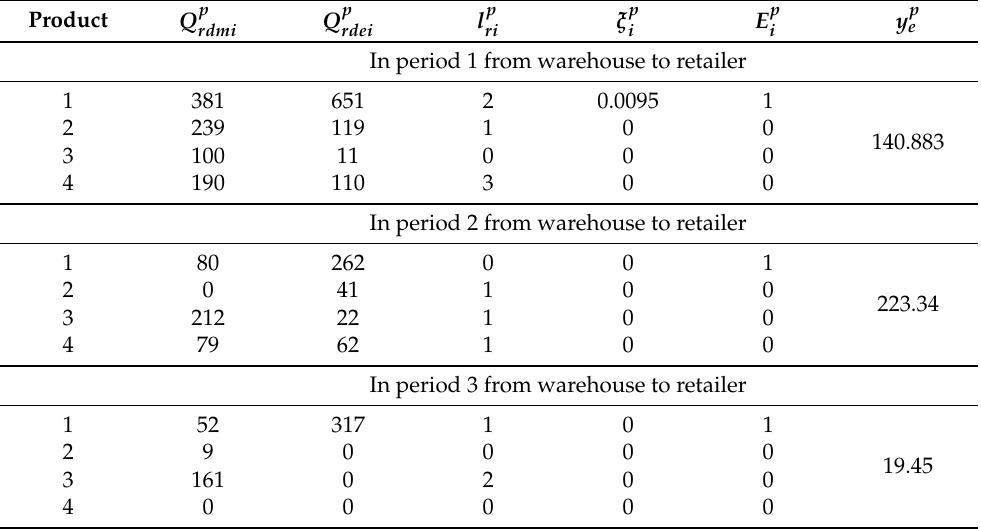
Table A13. Solution of our proposed model part